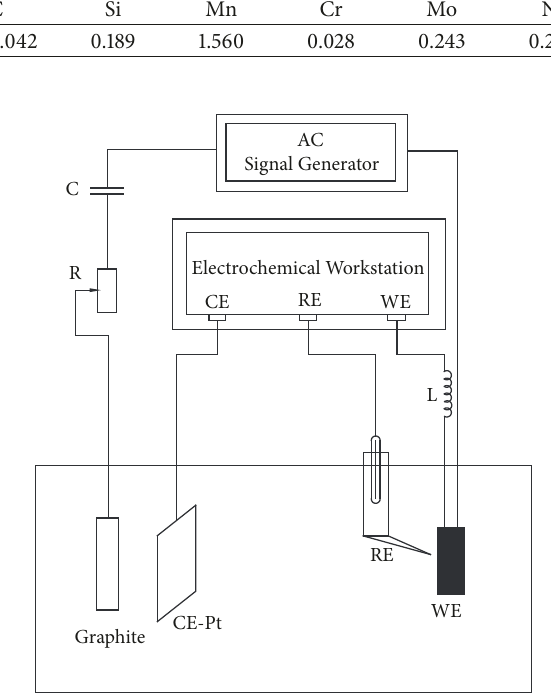
Figure 2: The diagram of the electrochemical test device.